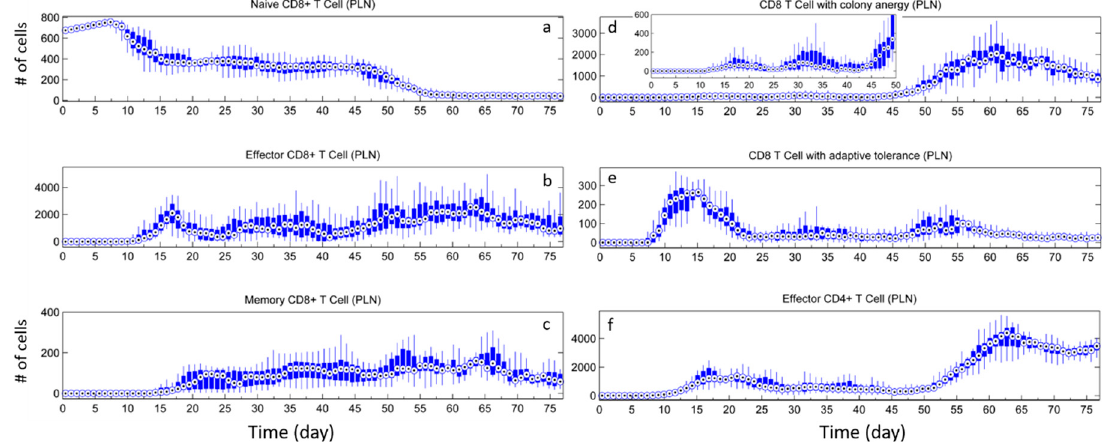
Figure 5. Simulation results for case without Tregs (case I). The number of ( a ) naive CD8 + T cells, ( b ) effector CD8 + T cells, ( c ) memory CD8 + T cells, ( d ) CD8 + T cells with colony anergy, ( e ) CD8 + T cells with adaptive tolerance, ( f ) effector CD4 + T cells in PLN are shown. Inserts (number of cells vs. time) show small change of cell number in the bottom figures. t = 0 day corresponds to 3-week age of mouse.